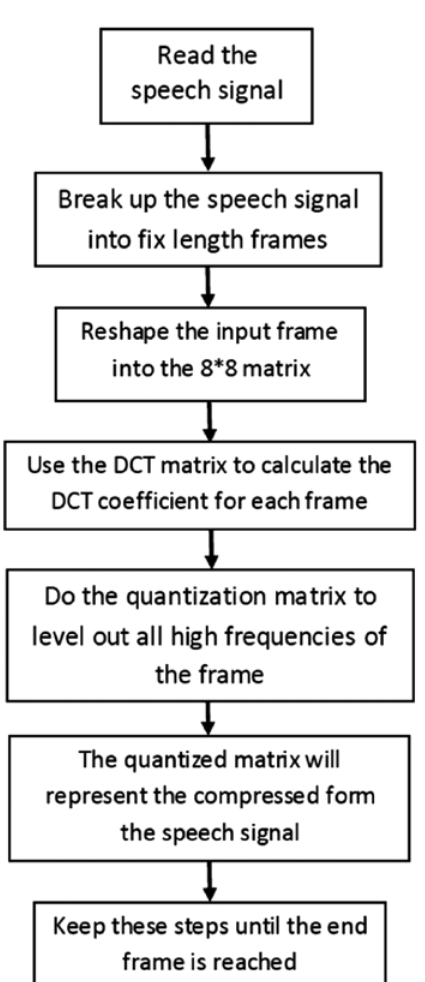
Figure 1: The Main Steps of the Out-Proposed Compression